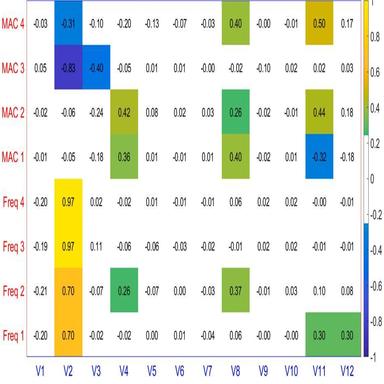
Matrix of Spearman correlation coefficients relating input parameters to output responses.